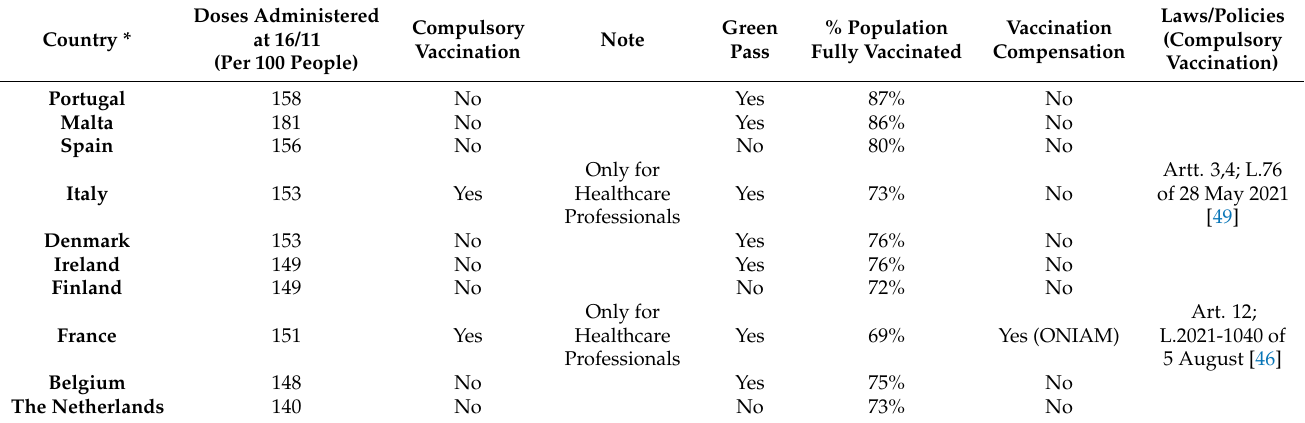
* Countries are sorted in descending order by vaccination coverage rate (data from: COVID World Vaccination Tracker—The New York Times. Available online: https://www.nytimes.com/interactive/2021/world/covid- vaccinations-tracker.html (accessed on 16 November